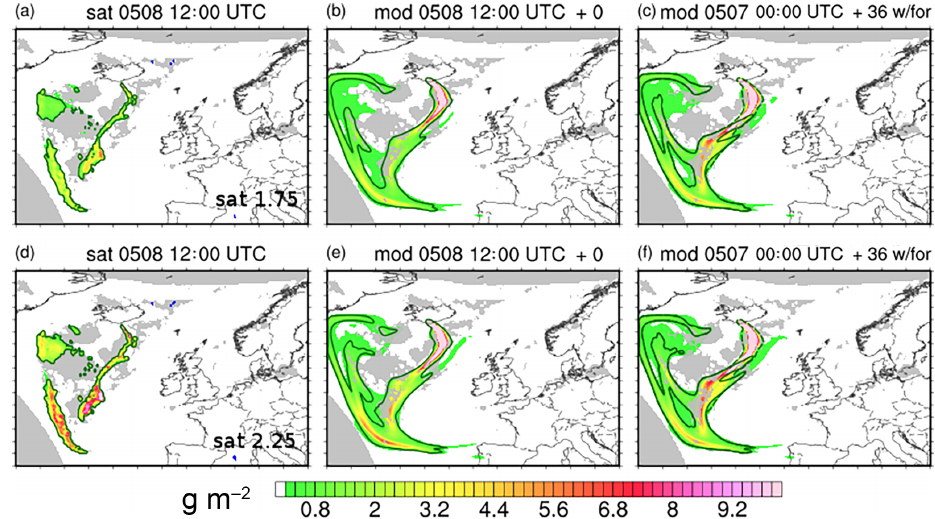
Figure 10. The same as Fig. 9 but for 8 May at 12:00UTC, showing the satellite data (a, d) and a posteriori model simulations for the first forecast hour (b, e) and 36h forecasts (c, f) with inversions for satellite retrieval data with the 1.75 (a, b, c) and 2.25 (d, e, f) size distribution